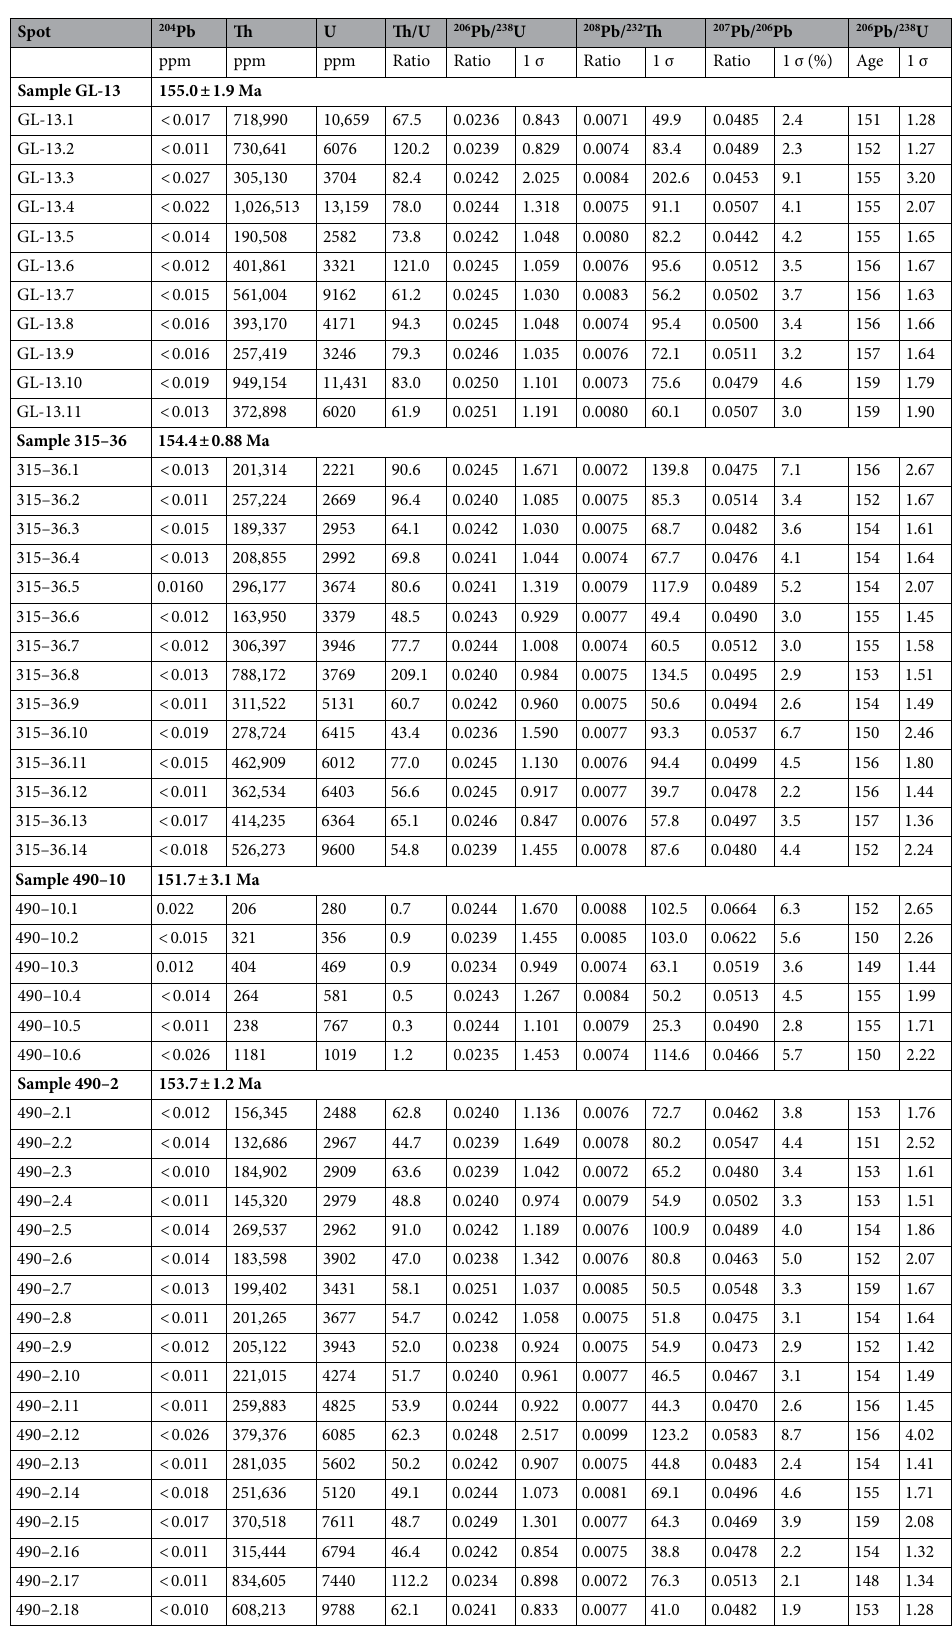
Table 1. LA-ICP-MS analyses of zircons in the